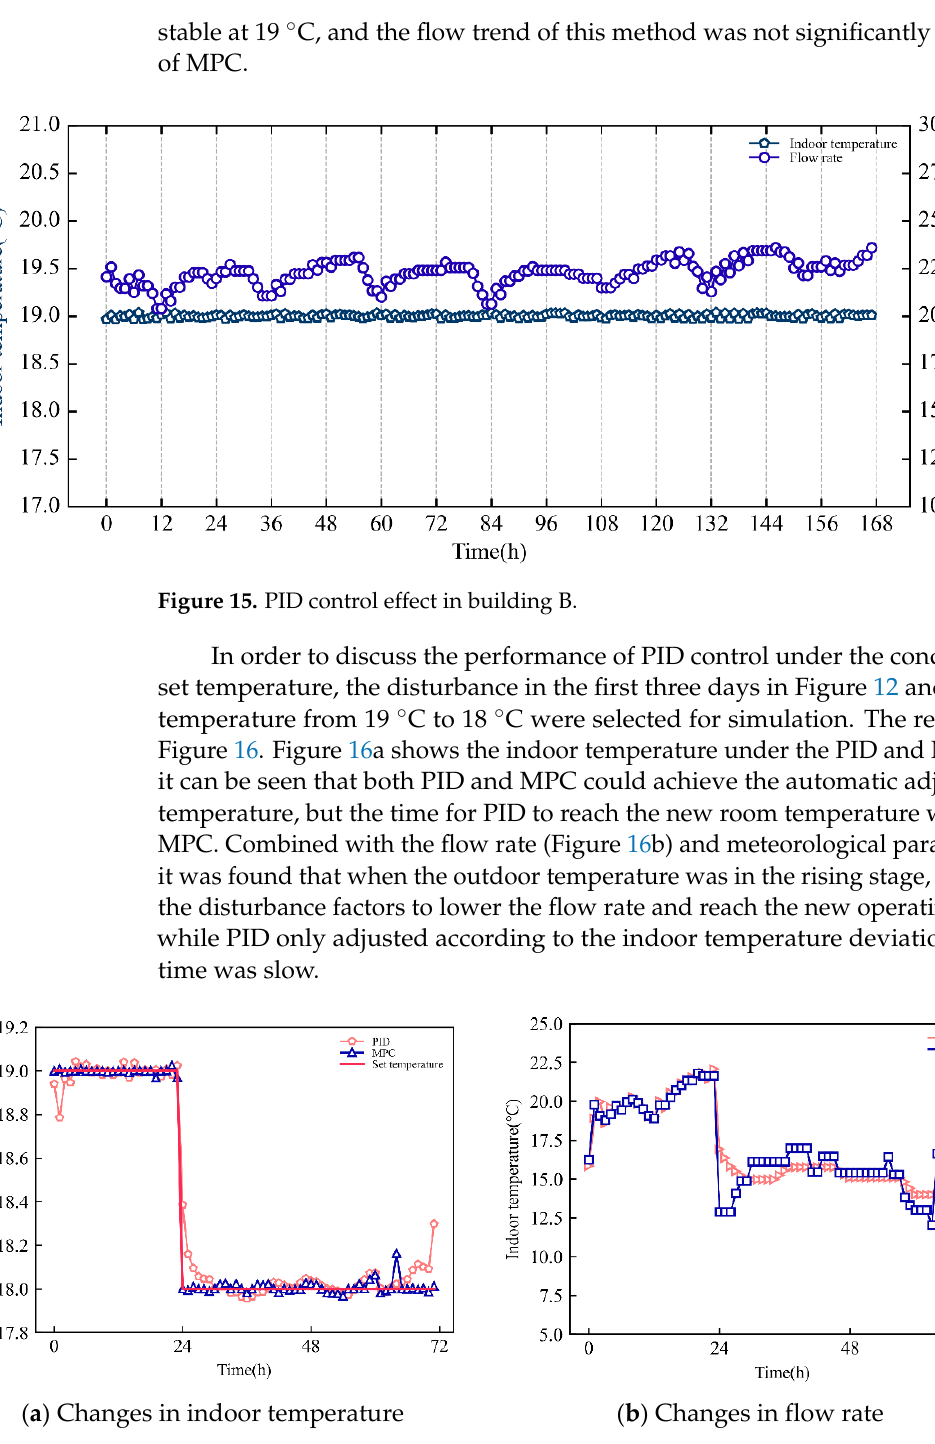
Figure 16. Comparison between PID and MPC under variable temperature settings.